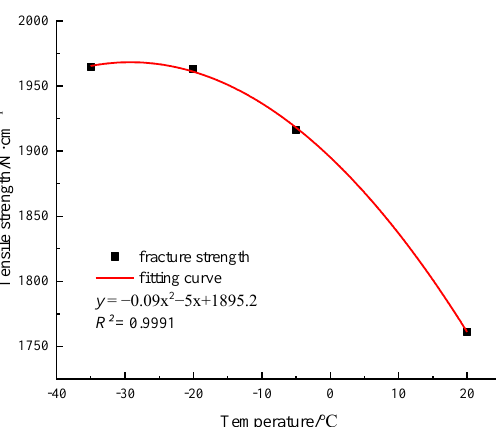
Figure 14. The tensile strength-temperature curve of the PET specimen.